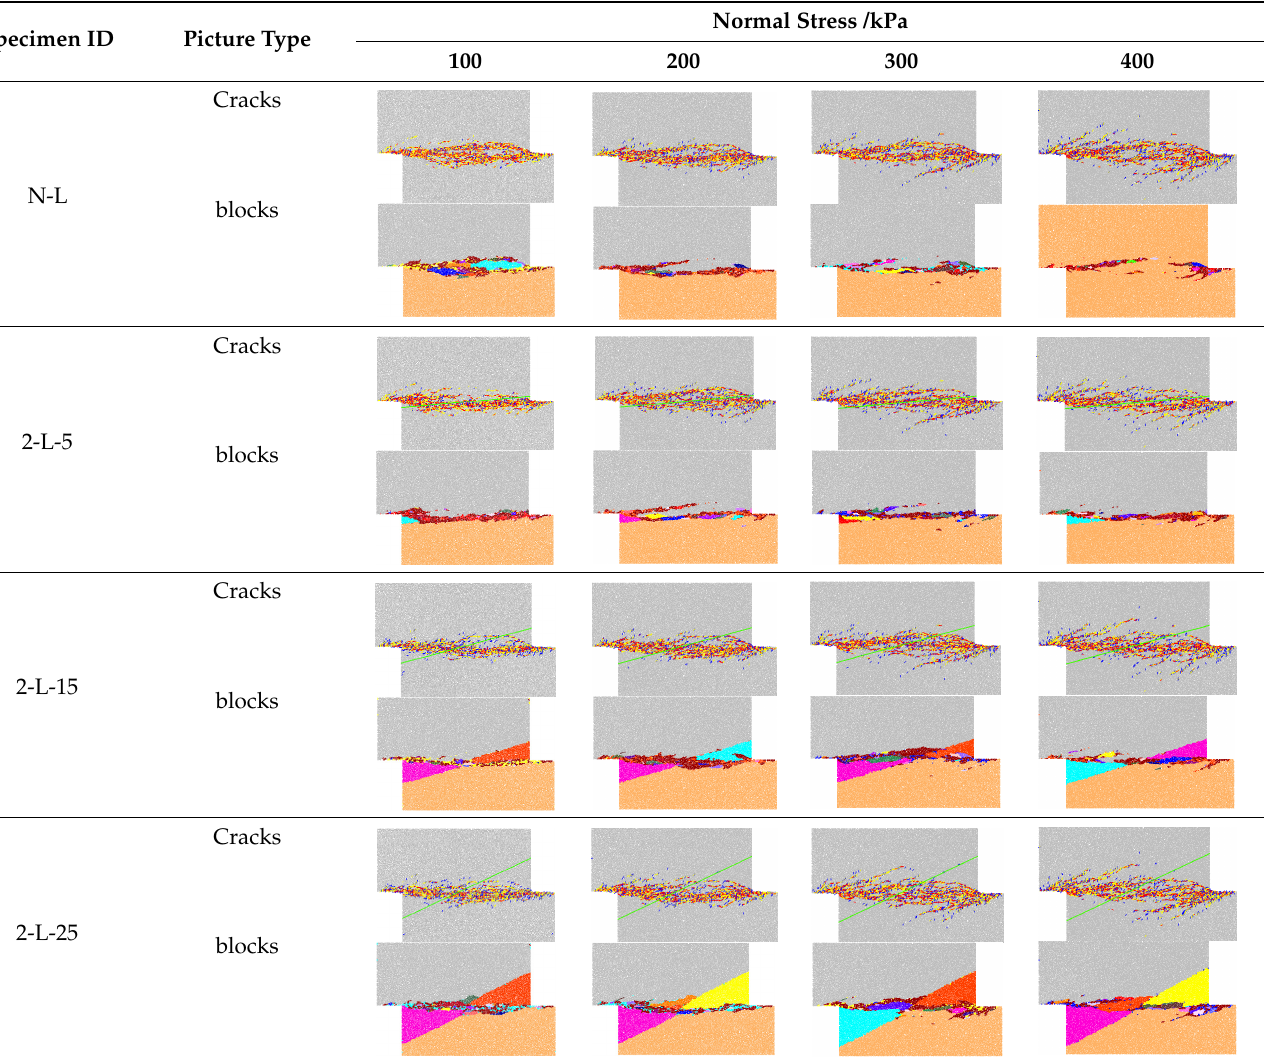
Table 6. Failure modes analysis of the CPB.